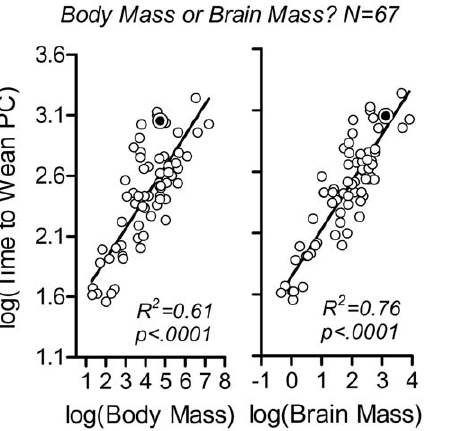
Figure 2. Brain mass is a better fundamental predictor of time to weaning than is female body mass. The continuous indepen- dent variables ‘female body mass’ and ‘adult brain mass’ were evaluated as potential predictors of time to weaning. Time to weaning (in days post conception; PC) was plotted as a function of female body mass (Body Mass, in grams) and adult brain mass (Brain Mass, in grams), in left and right panels, respectively. Note the log-log scales. Sample is as in Fig. 1 and Table S1 (N=67). Double circle: humans (this value represents the mean value for 46 natural fertility societies; see Fig. 5 [5]). Solid line: Model II linear regression (reduced major axis) on all species. R 2 - and p-values are given in the diagrams. R 2 -values indicate amount of variance accounted for by the respective model. Adult brain mass accounted for a larger amount of variance in time to weaning, demonstrating that this parameter is a better predictor of time to weaning than is female body mass.